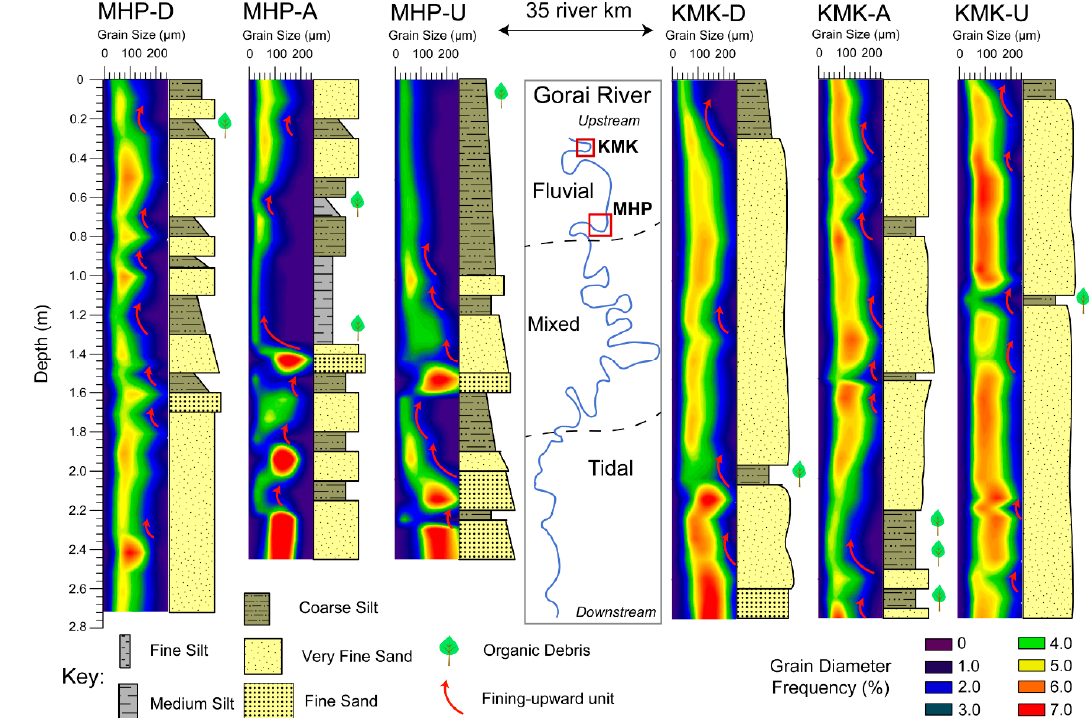
Figure 8. Core stratigraphy at Mohammadpur (MHP) and Kamarkhali (KMK), both of which are located within the fluvial depositional zone (mean tide range at MHP and KMK are ~0.2 m and 0 m, respectively). Note the thick (m-scale) and possibly amalgamated sand beds.